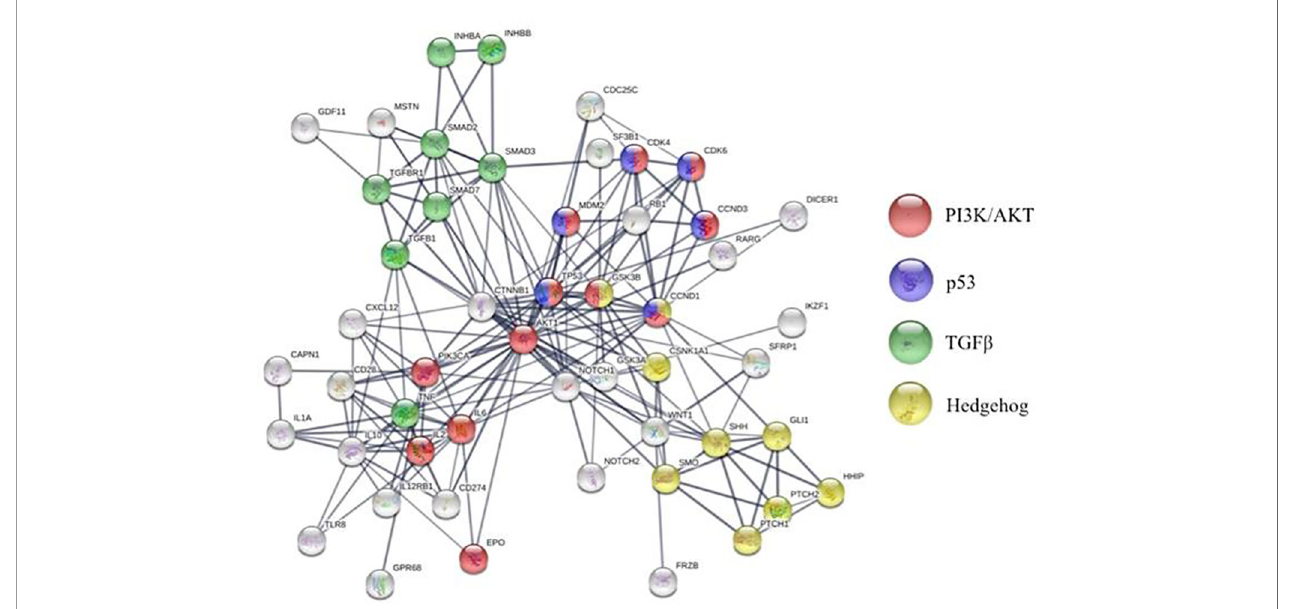
FIGURE 2 | STRING analysis of molecular pathways altered in bone marrow microenvironment of patients with MDS compared to healthy